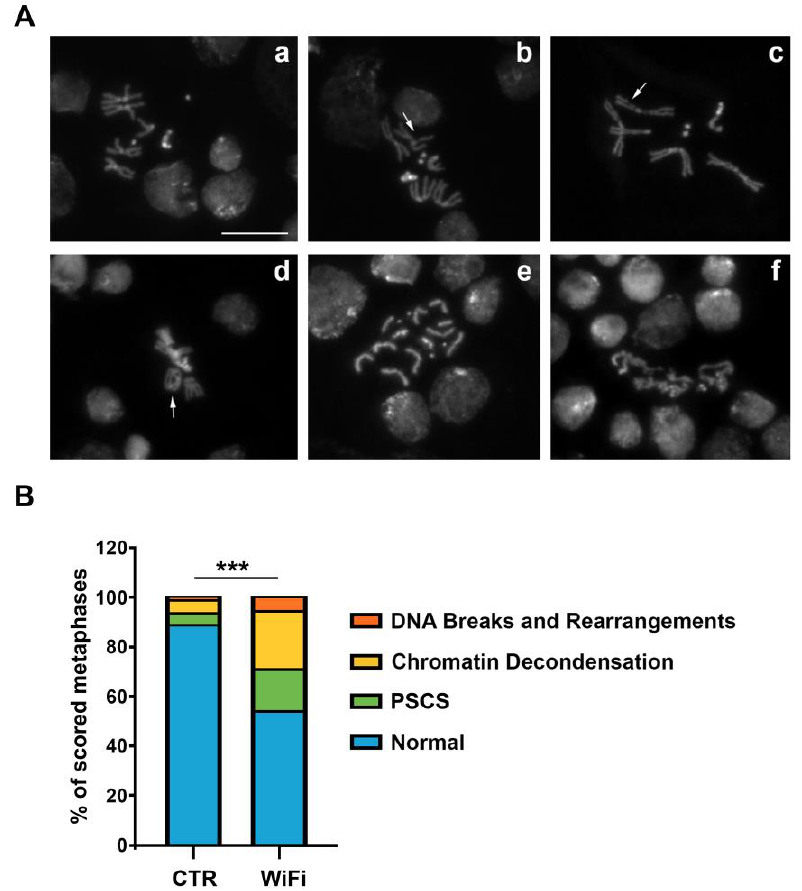
Figure 5. ( A ) DAPI-stained mitotic chromosomes obtained from control ( a ) and WiFi exposed ( b – f ) third-instar larval brains; ( a ) normal male metaphase; ( b – f ) examples of chromosome aberrations: DNA breaks (as indicated by arrows in b – c ), DNA rearrangement (as indicated by arrow in d ), PSCS ( e ) and chromatin decondensation ( f ). Scale bar indicates 10 µ m. ( B ) Quantification of chromosomal abnormalities observed in control and WiFi-exposed larval brains (*** p ≤ 0.001, Chi-square test). PSCS, Precocious Separation of Sister Chromatid. At least 200 metaphases were scored in each of three independent